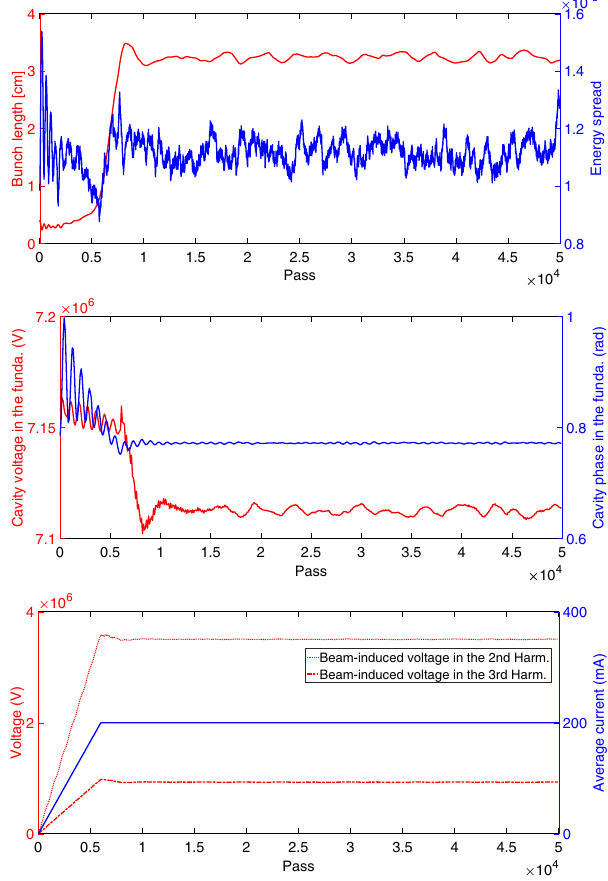
FIG. 8. The upper figure presents the longitudinal parameters of the beam vary with the number of passes, where the red line is the bunch length and the blue one is the energy spread. The center figure shows the cavity voltage and cavity phase of the main cavity along with the beam accumulated respectively. The bottom figure presents the beam-induced voltage in the 2nd hamonic and 3rd harmonic passive cavities, while the blue line stands for the average current in the storage